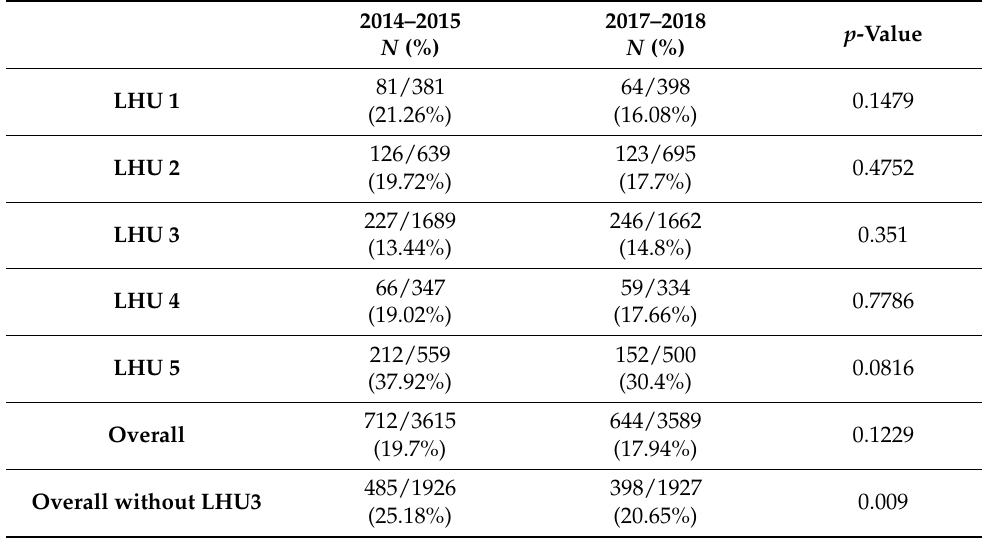
Table 2. Passive health migration rates for Local Health Unit (LHU) and period (before (2014–2015) and after (2017–2018) BU